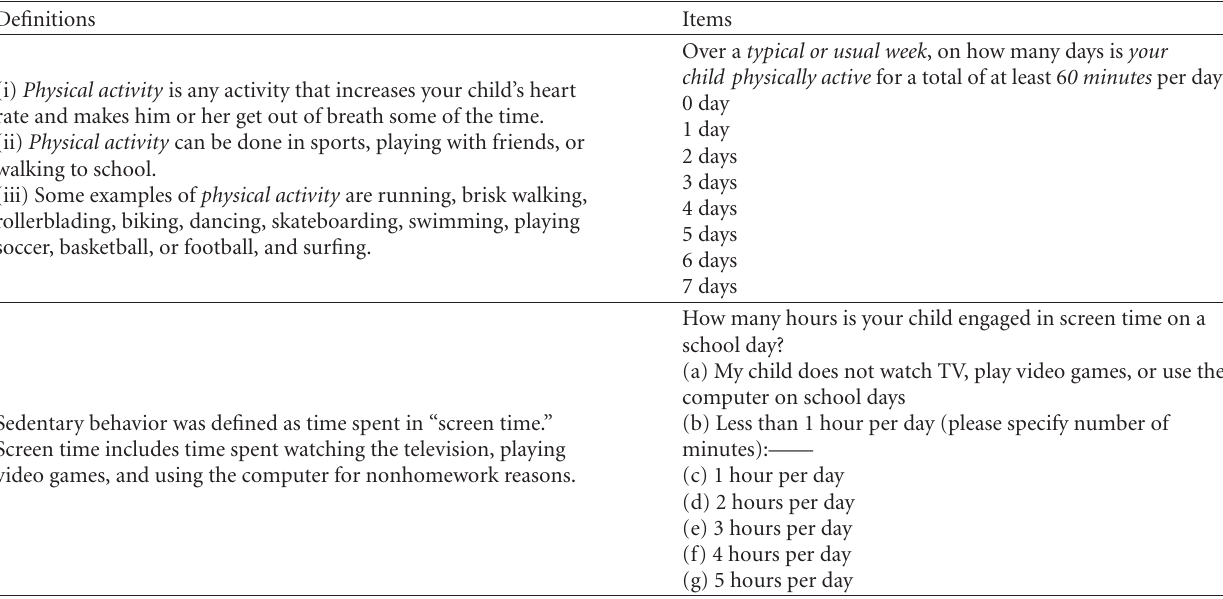
Table 4: PDHBQ items used in analysis.